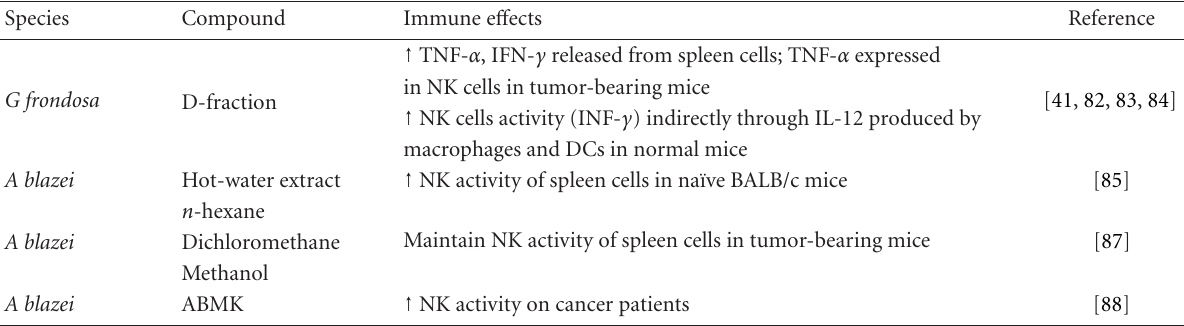
Table 3. Immunomodulatory activities of mushroom products on NK